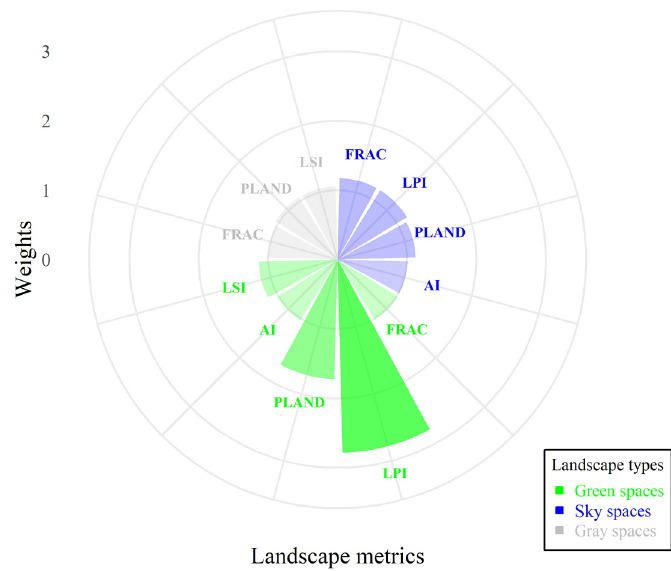
Figure 9. The estimated weights by the EWM in this study.